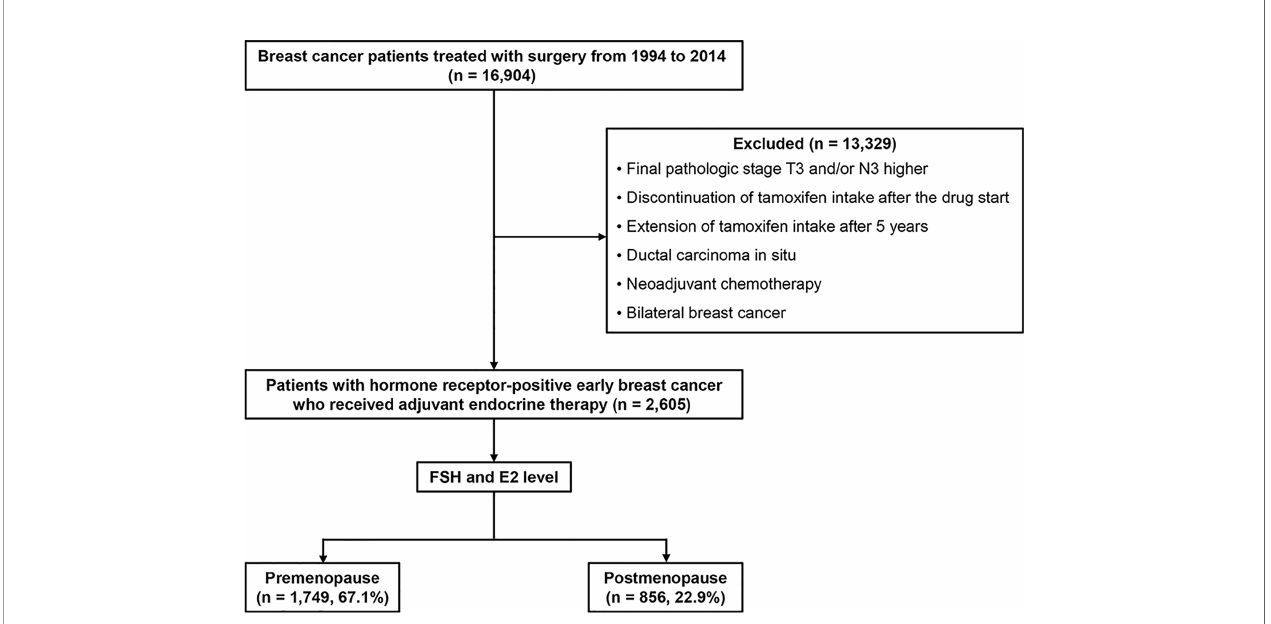
FIGURE 1 | Consort diagram of the study